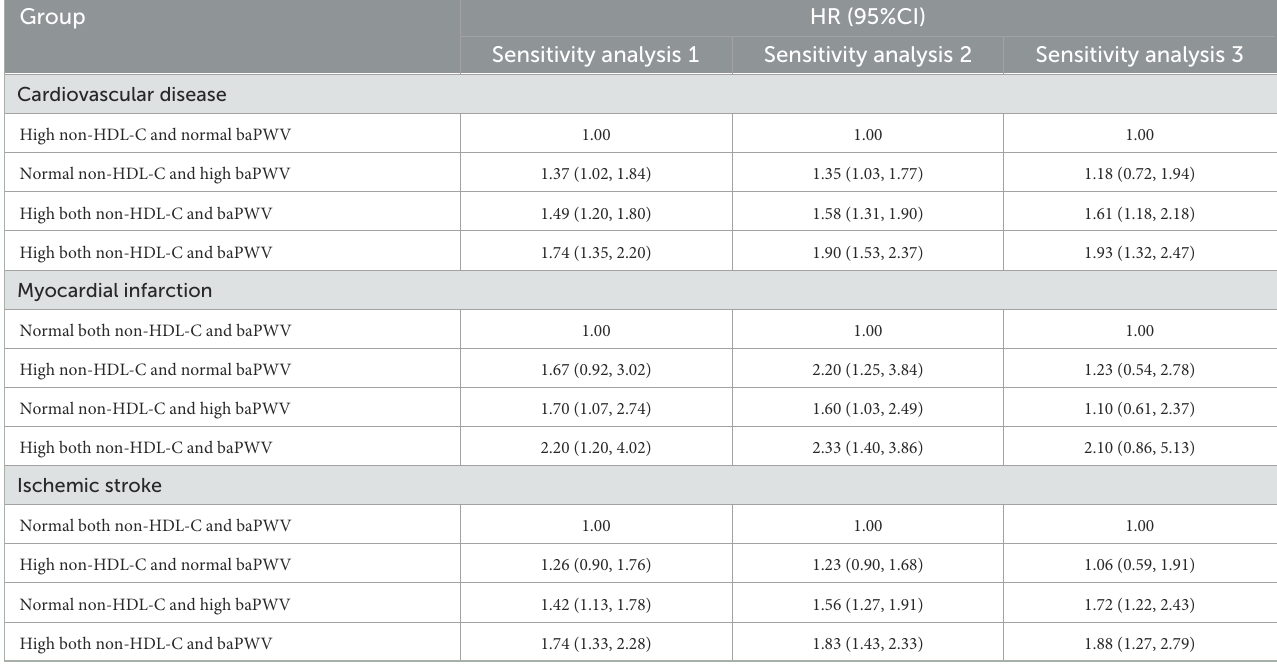
TABLE 5 Sensitivity analysis of the influence of the combined effects of non-HDL-C and baPWV on